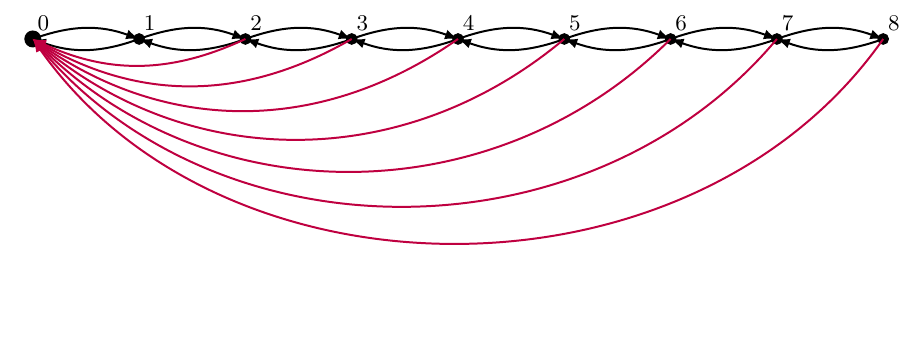
Figure 2: Catastrophes can lead from a state i ≥ 2 back to the x -axis in one